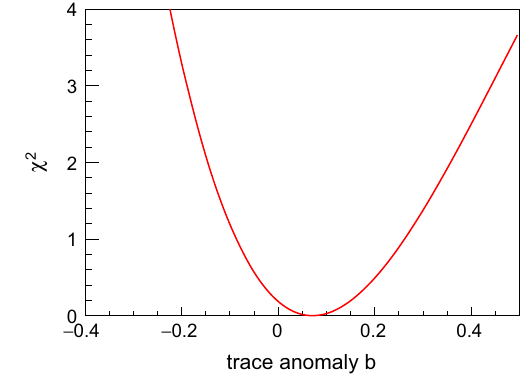
Fig. 3 χ 2 as a function of the QCD trace anomaly parameter b under a VMD model description. In the VMD model, (cid:14) 2 α ((cid:14) 2 ) = 0 . 494, and m s 0